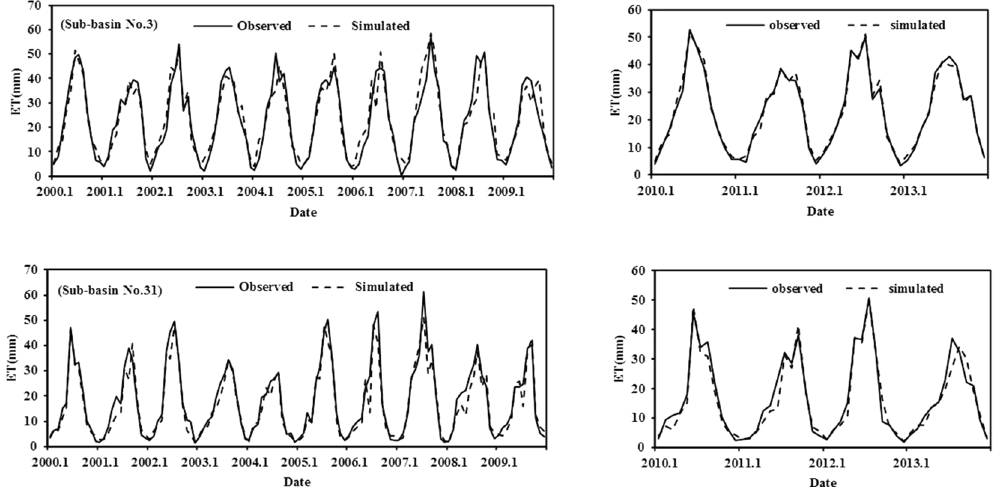
Figure 3. Simulated and observed monthly evapotranspiration (ET) at two typical sub-basins (numbers 3 and 31) for the calibration period (2000–2009) and the validation period (2010–2013).